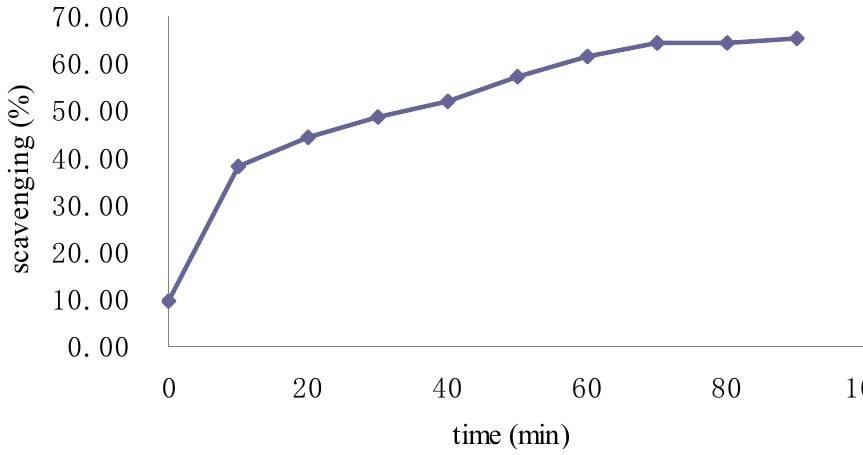
Figure 7. Percent scavenging of ABTS radical by Fuco over time.